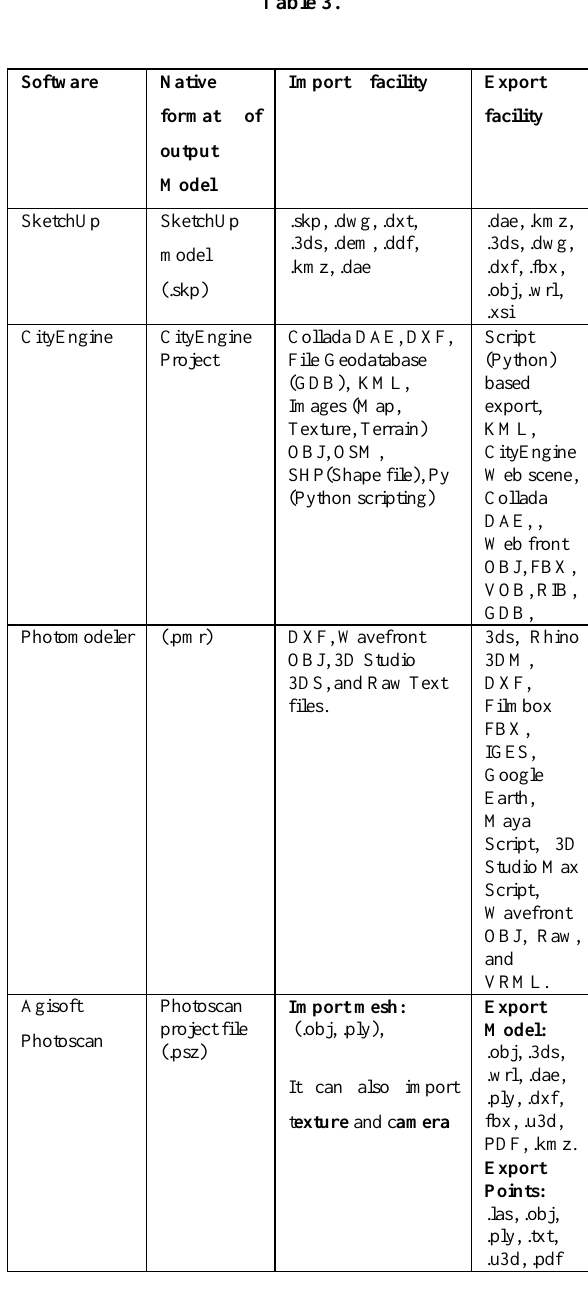
Table 2. Comparison of basic working principles (based on data